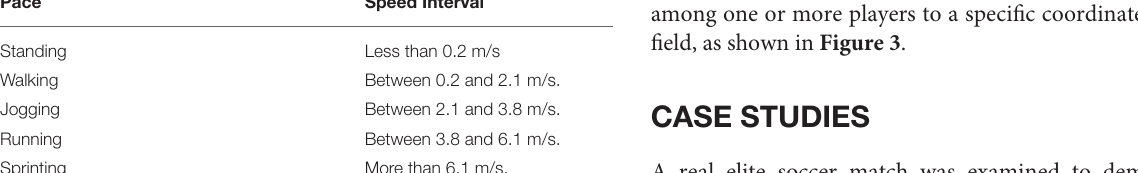
TABLE 1 | Description from the speed intervals used in the application. Pace Speed Interval Standing Less than 0.2 m/s Walking Between 0.2 and 2.1